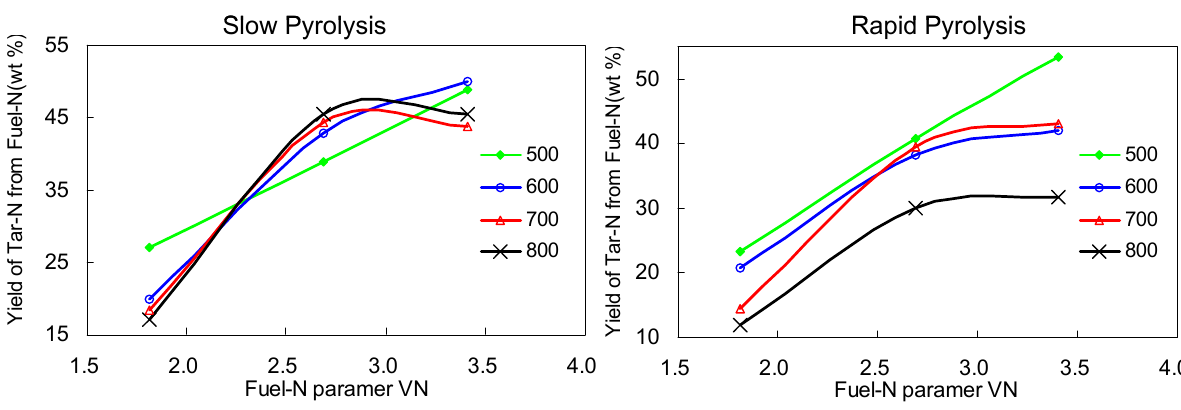
Figure 6. Tar-N yields from Fuel-N versus the Fuel-N parameter